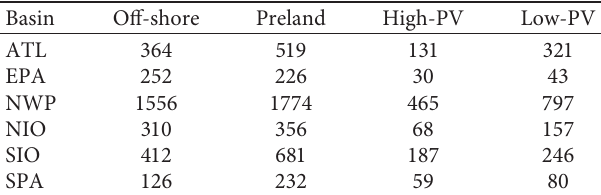
Table 1: Landing TC six-hourly samples in different periods over each basin during